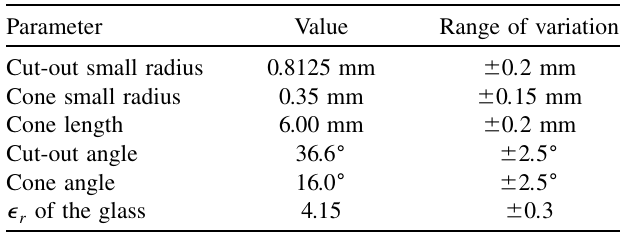
TABLE II. List of the most significant design parameters and the variation ranges as investigated in the tolerance study.